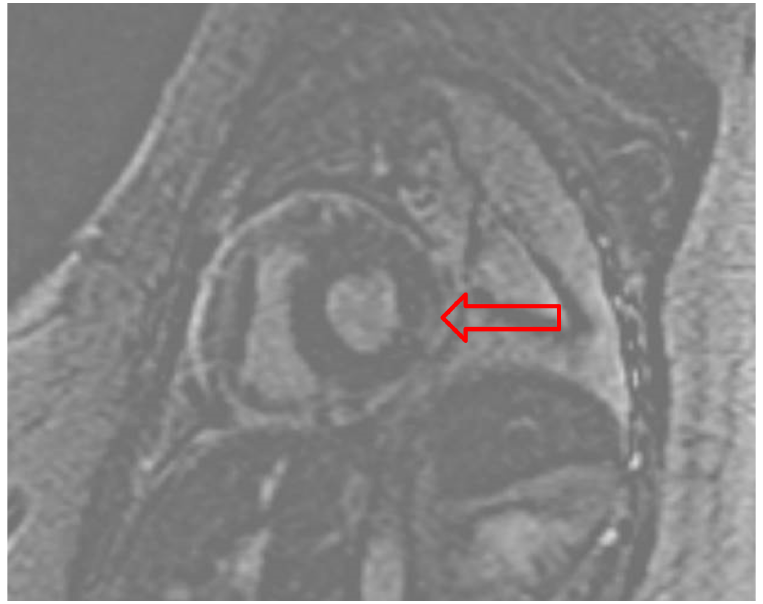
Figure 3. Gadolinium enhanced cardiac MRI pointing to the patchy sub-epicardial delayed enhance- ment of the basal lateral/inferolateral wall (red arrow).